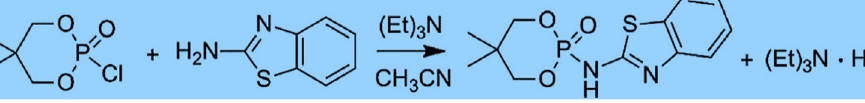
Figure 8. Synthetic route of DOP-ABZ.